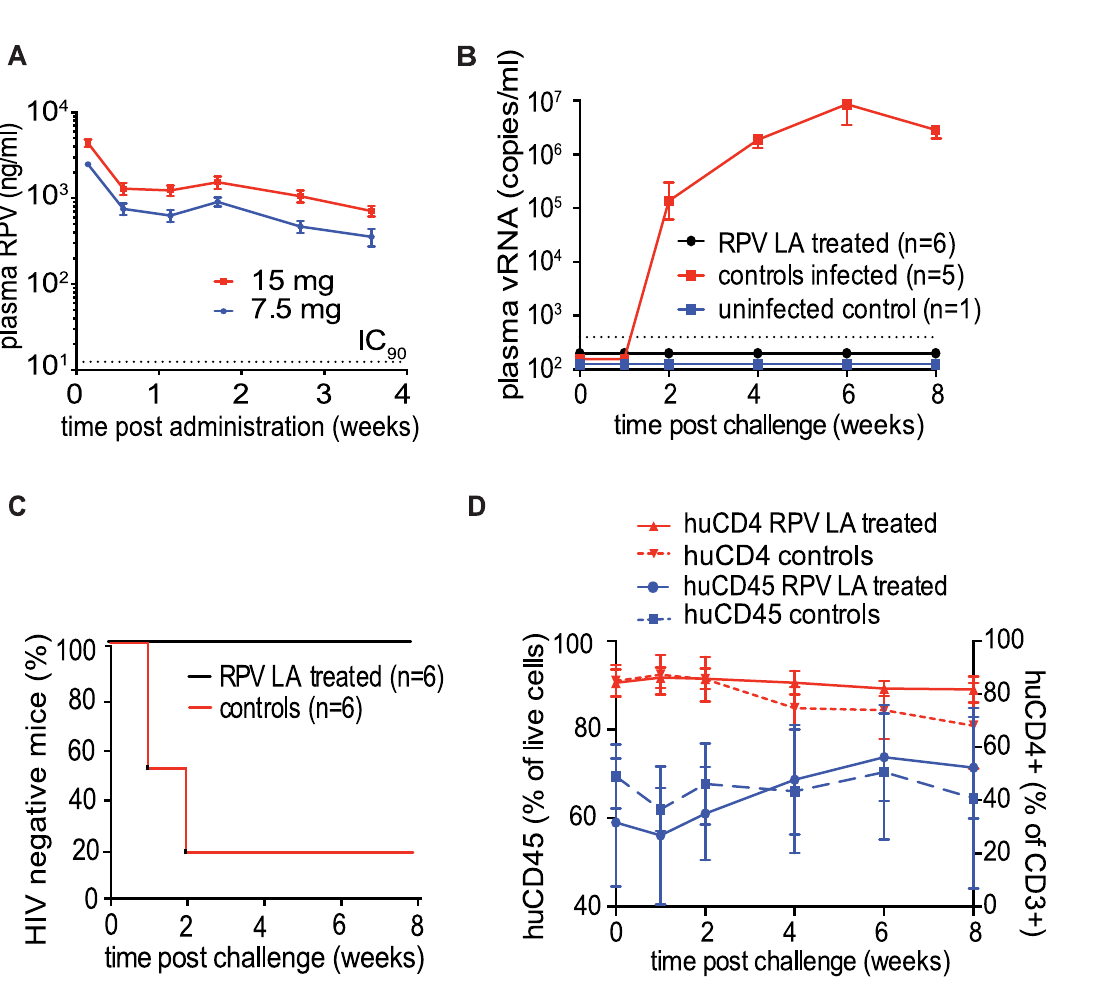
Fig 4. Ability of RPV LA to offer coitus-independent protection from vaginal HIV-1 transmission in BLT mouse. (A) Longitudinal analysis of RPV levels in plasma of NSG mice injected intramuscularly once with 7.5 mg or 15 mg RPV LA (n = 4 for each group, dotted line indicates IC 90 ). (B) Plasma viral RNA in BLT mice challenged vaginally with HIV-1 CH040 (3.5×10 5 TCID), a transmitted/founder virus 1-week post administration of RPV LA (15 mg, n = 6) or vehicle (n = 6) intramuscularly. Shown are plasma viral RNA (dotted line-LOQ 400 copies of RNA per ml of plasma). (C) Kaplan-Meier plots representing the percentage of BLT mice protected from HIV transmission by RPV LA as a function of the number of weeks post challenge until the first peripheral blood viral RNA detection. Protected animals were negative for viral RNA in plasma and viral DNA in tissue analyzed after necropsy (P = 0.0047, Log rank/Mantel Cox test). (D). Human CD45 cell levels in peripheral blood (percent of total live cells) and human CD4 levels (percent of human CD3 positive cells) were analyzed by flowcytometry at the indicated times. Solid lines: RPV LA treated mice, dashed lines: control